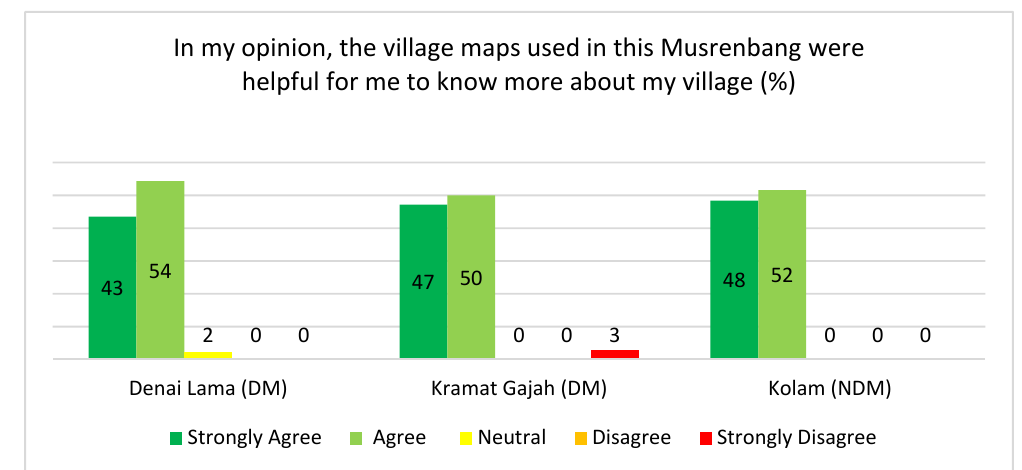
Figure 3. The helpfulness of village maps to the respondents for knowing more about their villages.